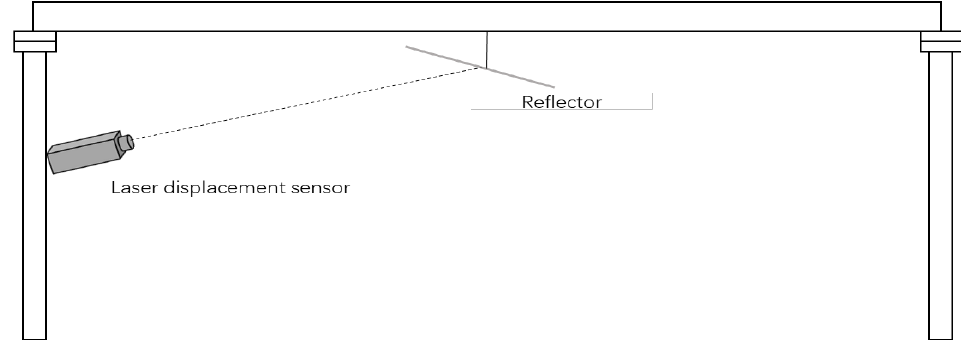
Figure 4. Schematic diagram of displacement measurement with laser displacement sensor.